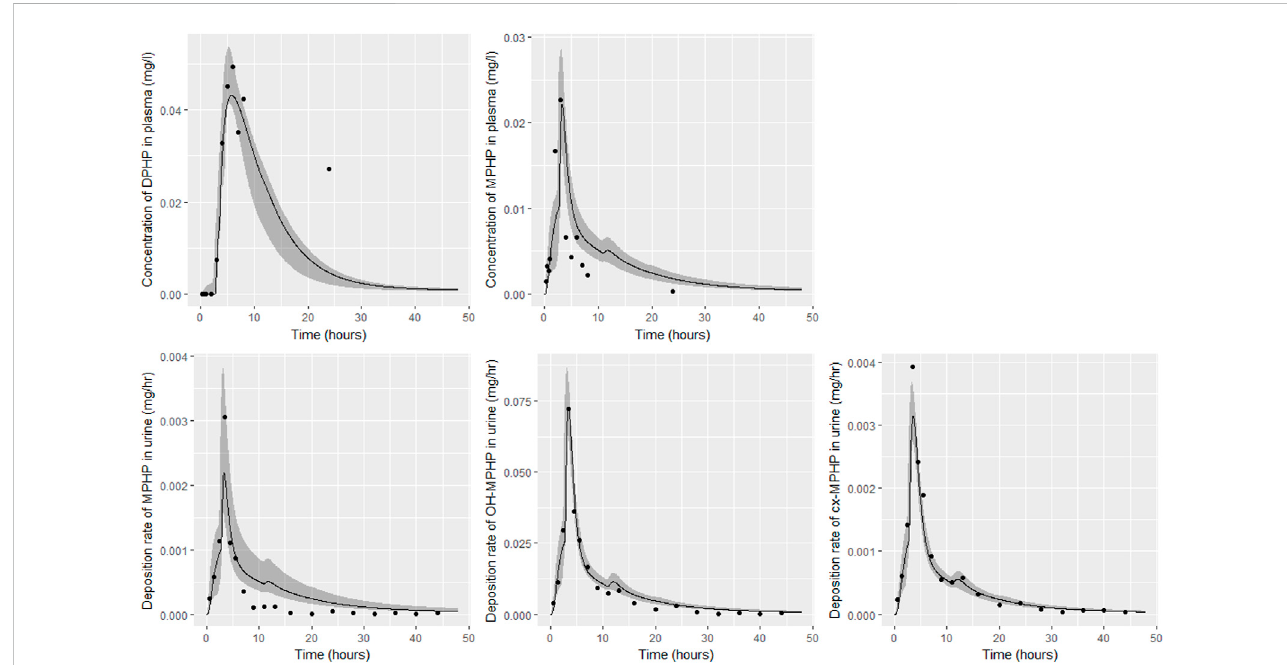
FIGURE 8 Fitofthecalibratedmodel to datafrom individual (D) .Panel (A) DPHP invenousblood(mg/L); (B) MPHP invenousblood (mg/L); (C) rate ofdepositionof MPHP into the bladder; (D) rate of deposition of OH-MPHP into the bladder; and (E) rate of deposition of cx-MPHP into the bladder. The central estimates indicated in plots correspond to the posterior mode whereas the shaded regions represent 95% intervals for the respective